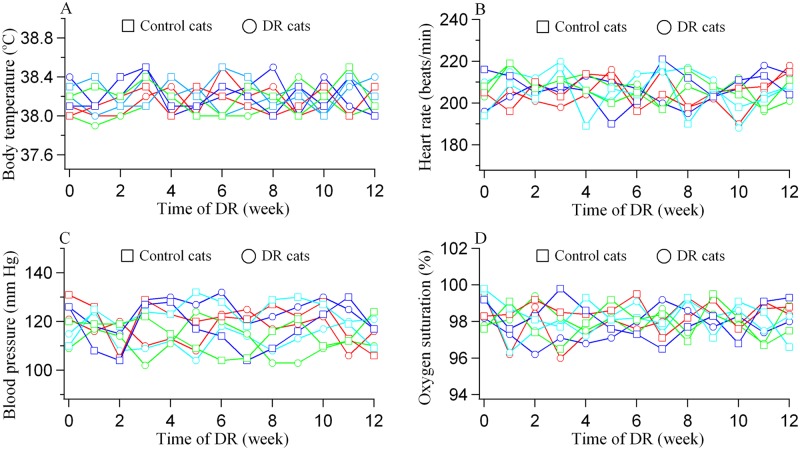
Record of body temperature (A), heart rate (B), femoral artery contraction blood pressure (C) and blood oxygen saturation (D) for each DR cat and control cat during the period of DR.Open squares represented normal control cats (NC1: red; NC2: blue; NC3: cyan; NC4: green). Open circles denoted DR cats (DR1: red; DR2: blue; DR3: cyan; DR4: green).